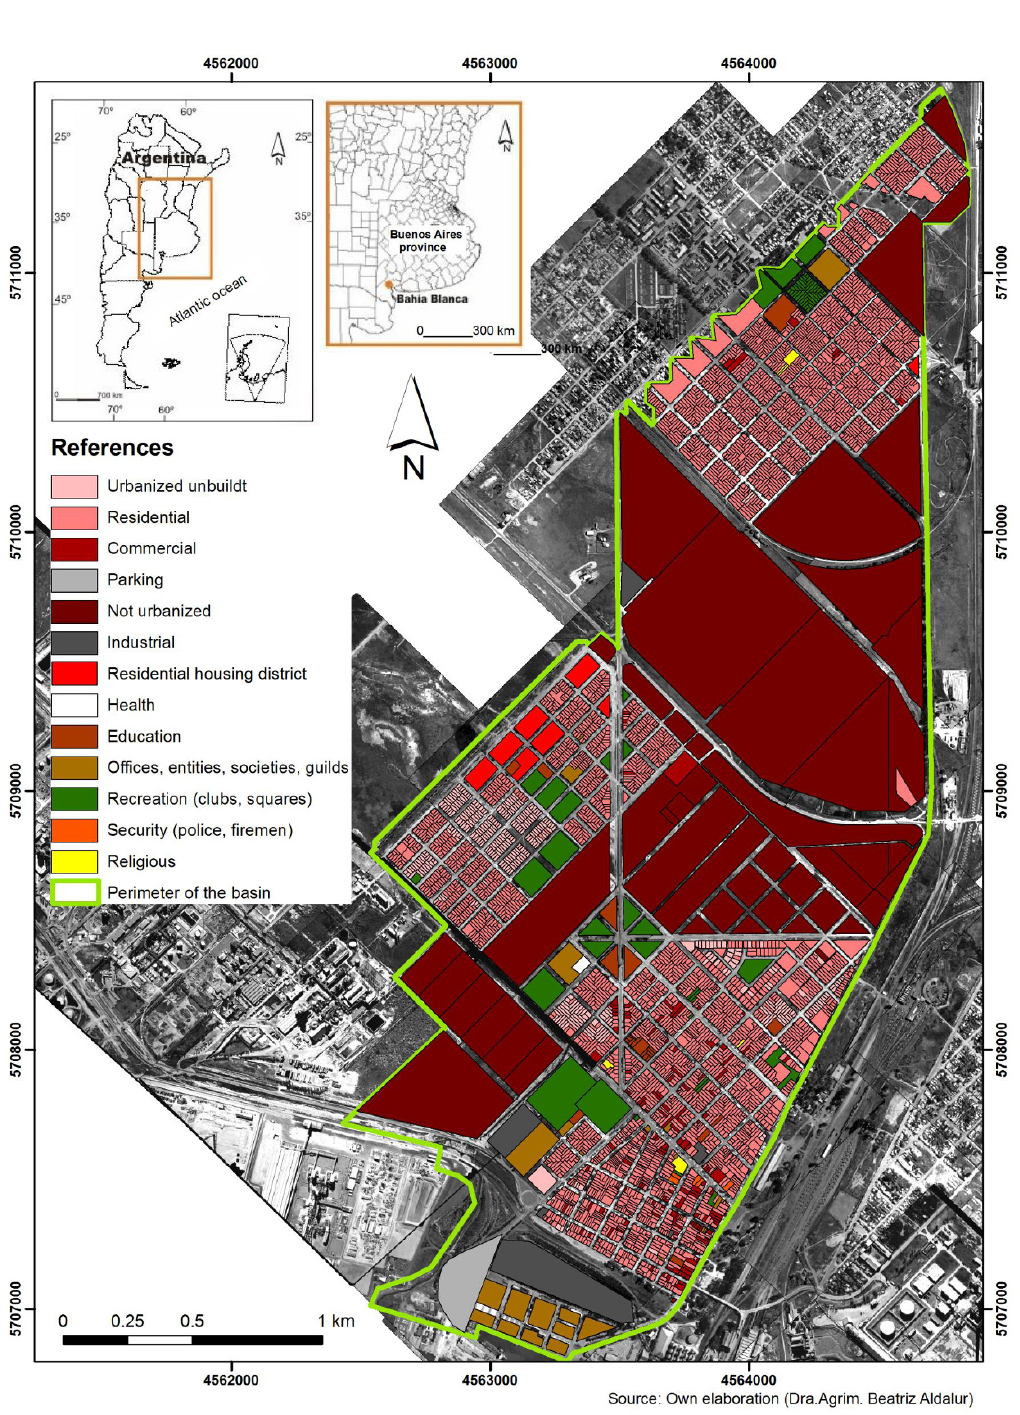
Figure 6. Land use of